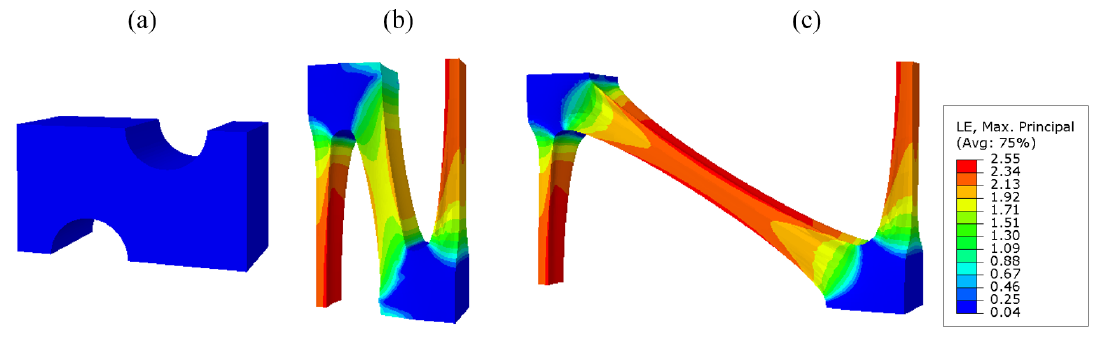
Figure 15. Strain cloud map of the triaxial geogrid stretch forming simulation. ( a ) Before longitudinal stretching, ( b ) after longitudinal stretching, ( c ) after transverse